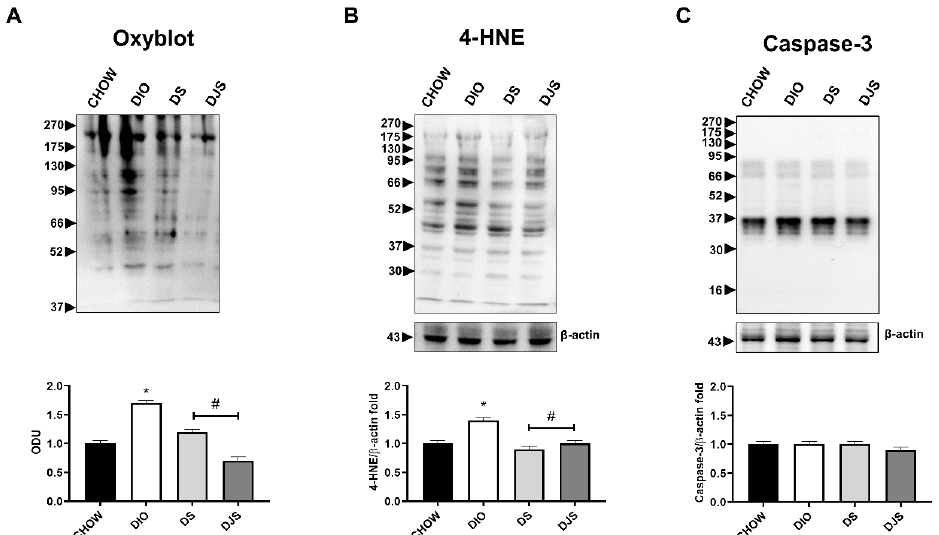
Figure 3. Oxidative stress and apoptosis. ( A ) Oxyblot in cardiac samples and the graph shows the measurements of optical density expressed as arbitrary optical density unit (ODU). Cardiac lysates were immunoblotted with anti-4-Hydroxynonenal (4-HNE) ( B ) and anti-Caspase-3 ( C ). Graphs show the densitometric ratios of bands and β -actin expression, used to normalize the data. CHOW rats ( n = 8), reference group fed with standard diet; DIO rats ( n = 9), fed with high-fat diet; DS ( n = 12), DIO rats supplemented with tart cherry seeds; DJS ( n = 9), DS rats supplemented with tart cherry juice. Data are mean ± SEM. * p < 0.05 vs. CHOW rats; # p < 0.05 vs. DIO rats.